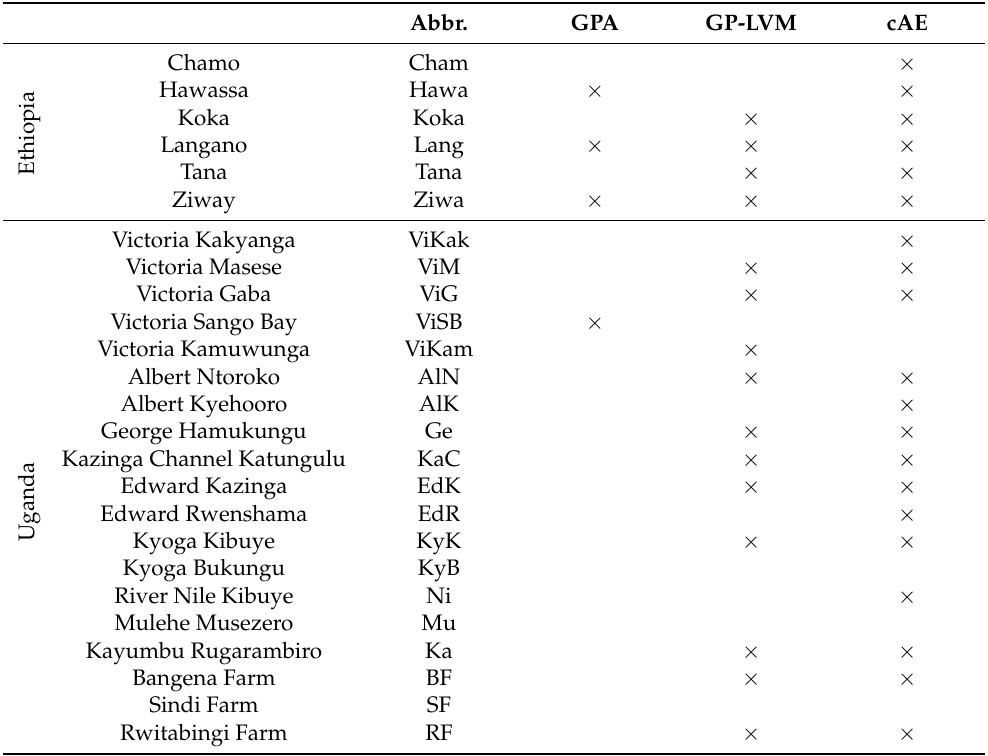
Table 3. Summary of results obtained with generalized procrustes analysis (GPA), Gaussian process latent variable models (GP-LVM) as well as deep convolutional autoencoder (cAE). The significantly different locations are indicated with a cross ( ×